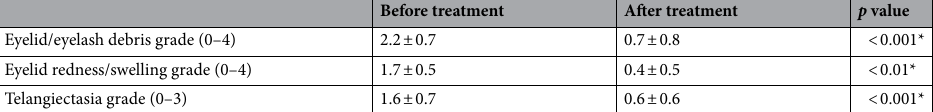
Before treatment After treatment p